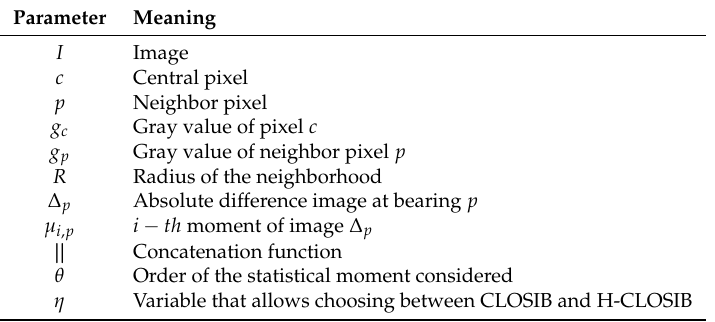
Table 2. CLOSIB variants